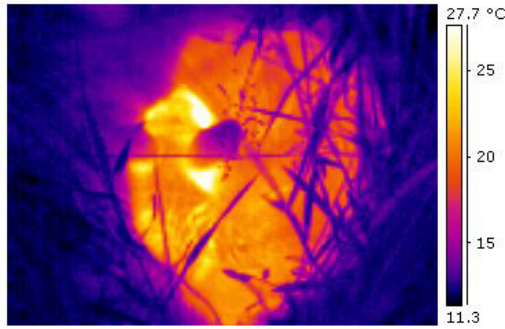
Figure 1: thermal image of a